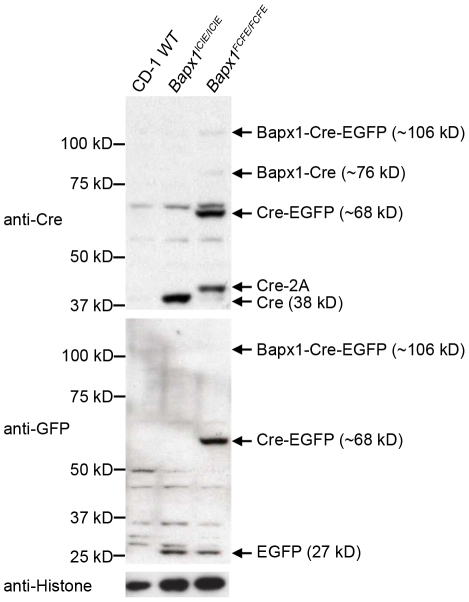
Efficiency of the IRES and the F2A at the Bapx1 locus assessed by Western blotting.Lysates from E12.5 CD-1 WT, Bapx1ICIE/ICIE and Bapx1FCFE/FCFE embryos were resolved on SDS-PAGE and immunoblotted with anti-Cre (top panel) and anti-GFP (middle panel) antibodies. Top panel: Faint bands were detected for Bapx1-Cre-EGFP and Bapx1-Cre fusion proteins at the predicted molecular weights in Bapx1FCFE/FCFE; significant amounts of Cre-EGFP fusion proteins and Cre-2A (2A – residual 23 amino acids of F2A) were also detected. No fusion proteins or Cre-2A, but Cre (38 kD), were detected in Bapx1ICIE/ICIE. Middle panel: Cre-EGFP but not Bapx1-Cre-EGFP fusion protein was detected in Bapx1FCFE/FCFE; EGFP of predicted molecular weight was detected in both Bapx1ICIE/ICIE and Bapx1FCFE/FCFE, but not in the negative control (CD-1 WT). Bottom panel: immunoblotting with anti-histone antibody showed equal loading.